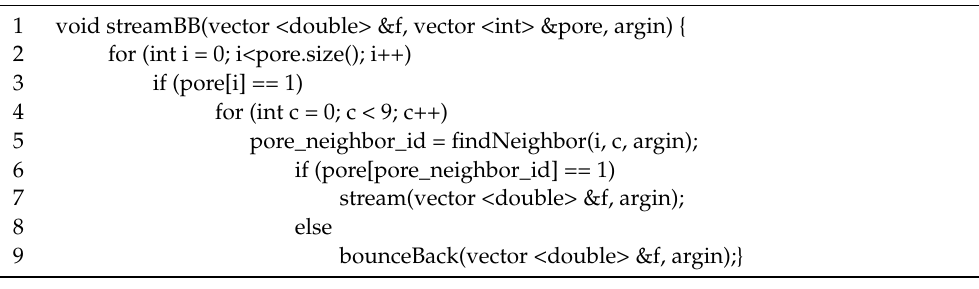
Algorithm 3. Finding pore indices before the start of simulation—“ids_pores” stores all the